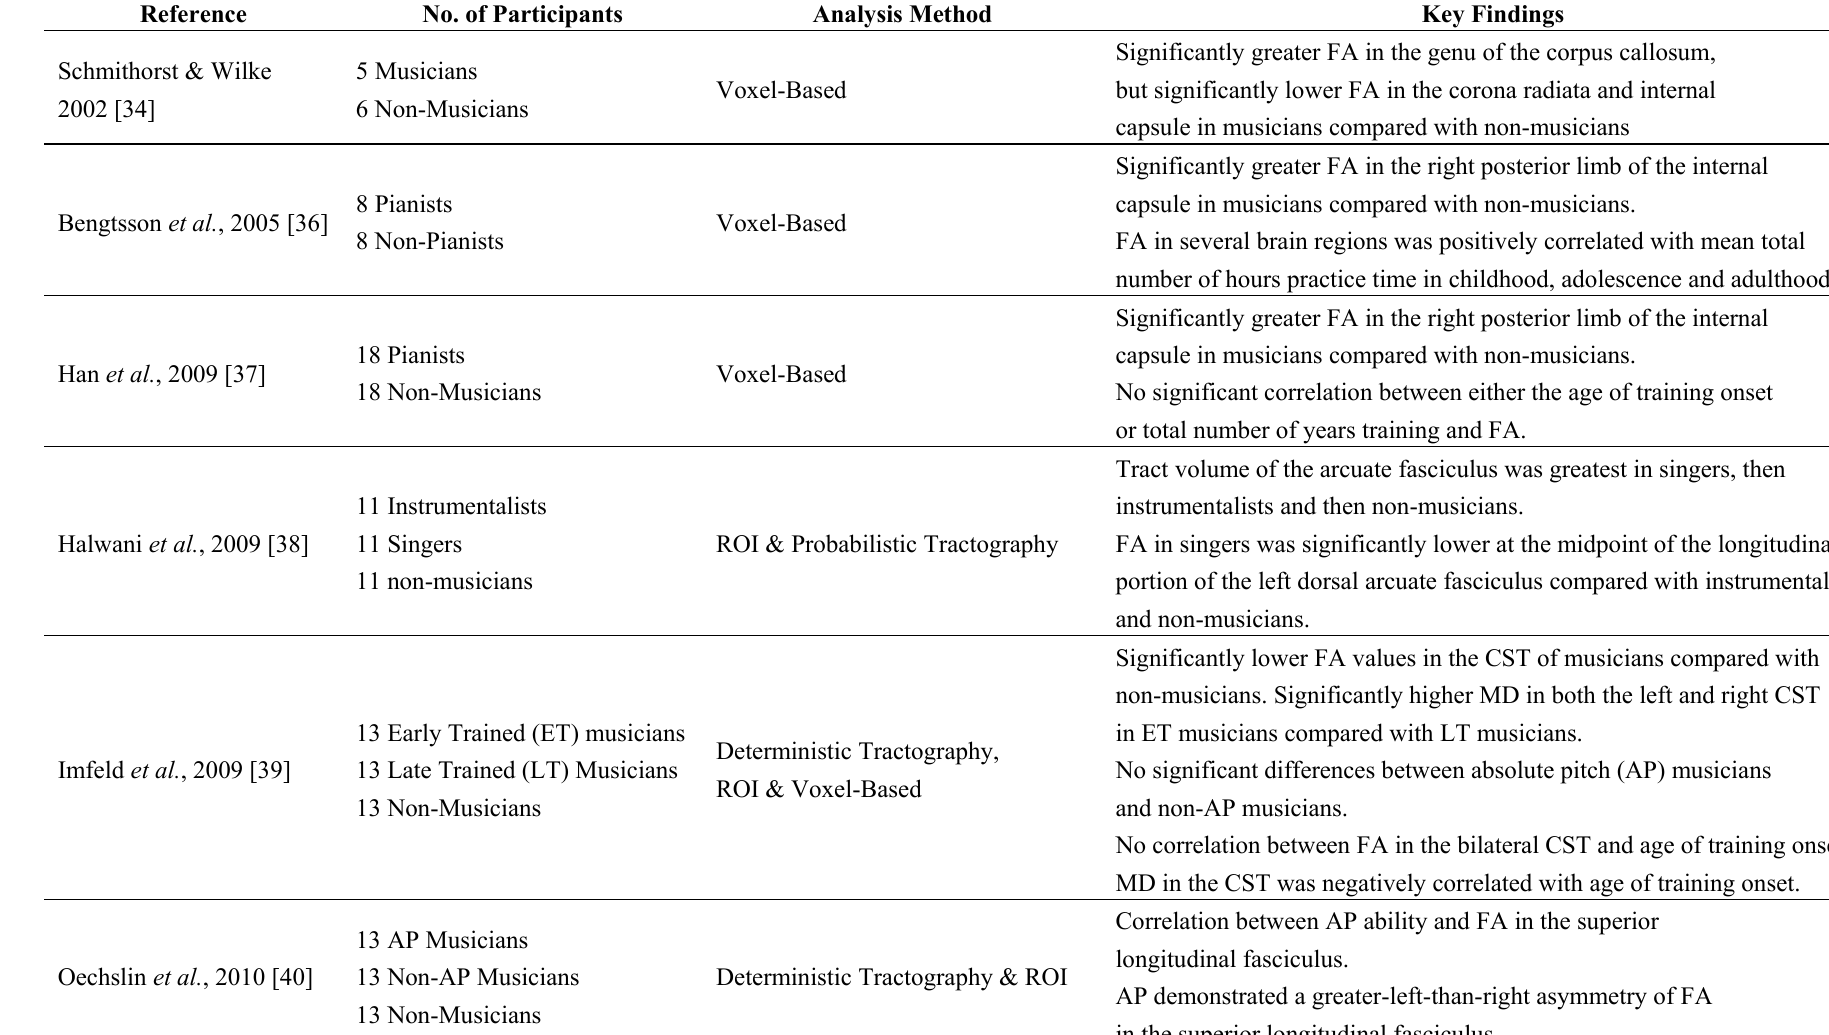
Table 1. Overview of studies and